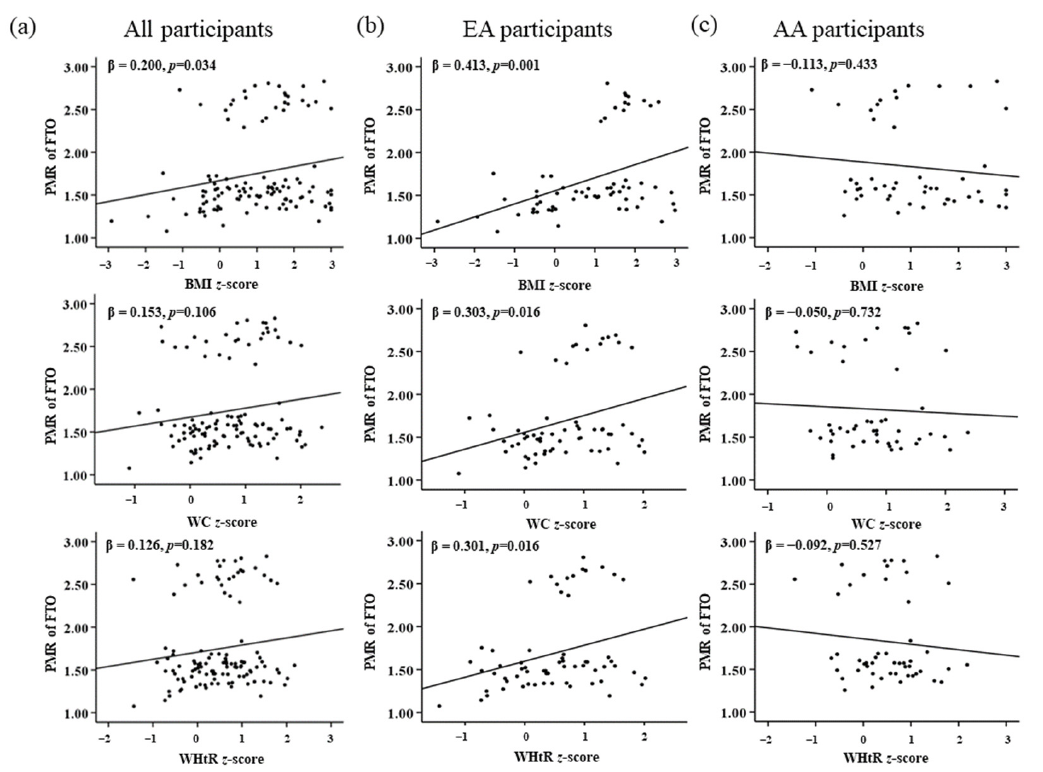
Figure 3. Association of FTO with childhood obesity markers of ( a ) all, ( b ) EA, and ( c ) AA participants. p < 0.05 is considered statistically significant.